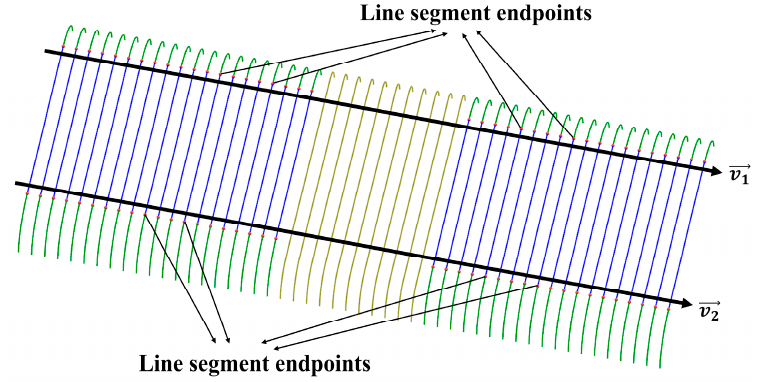
Figure 9. Fitting the endpoints of line segments with a model of line to acquire the preliminary extension vectors